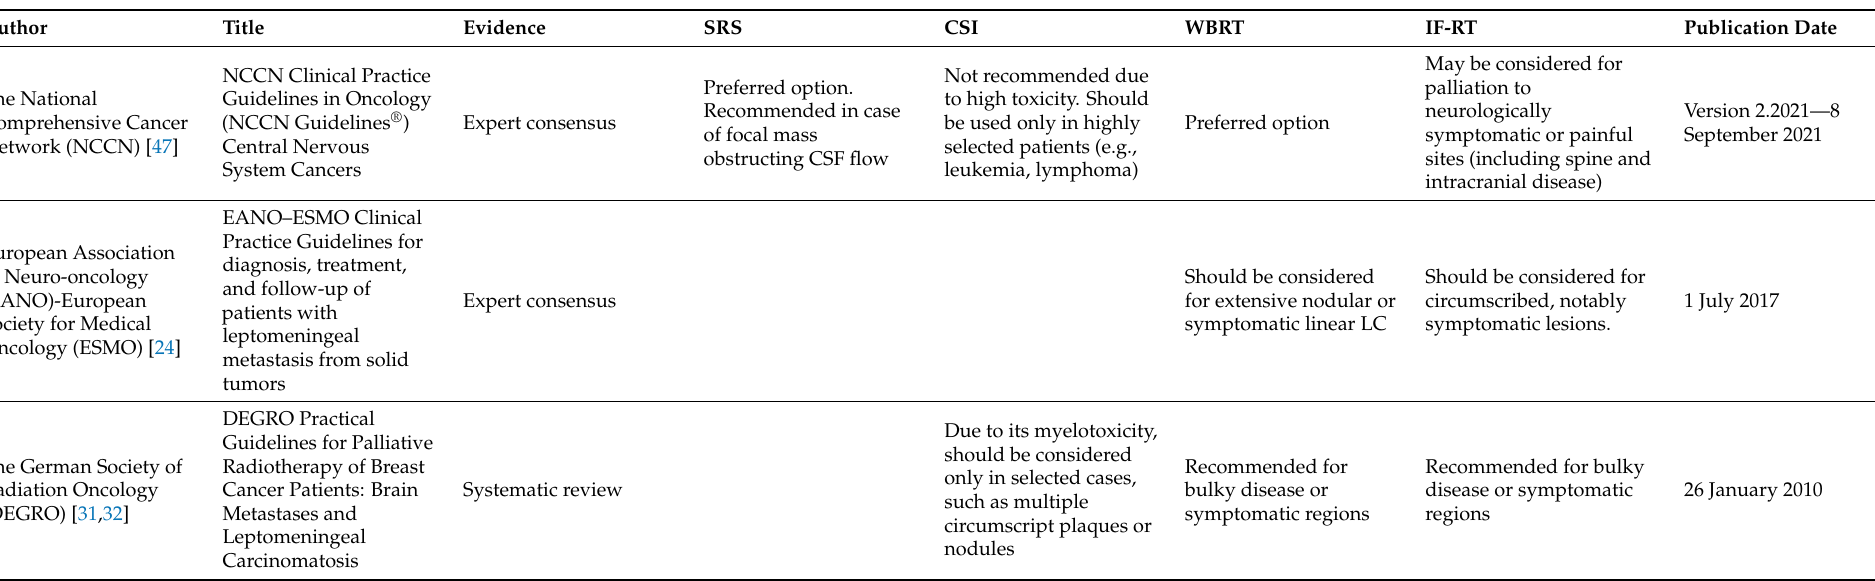
Table 4. Radiotherapy guidelines for leptomeningeal